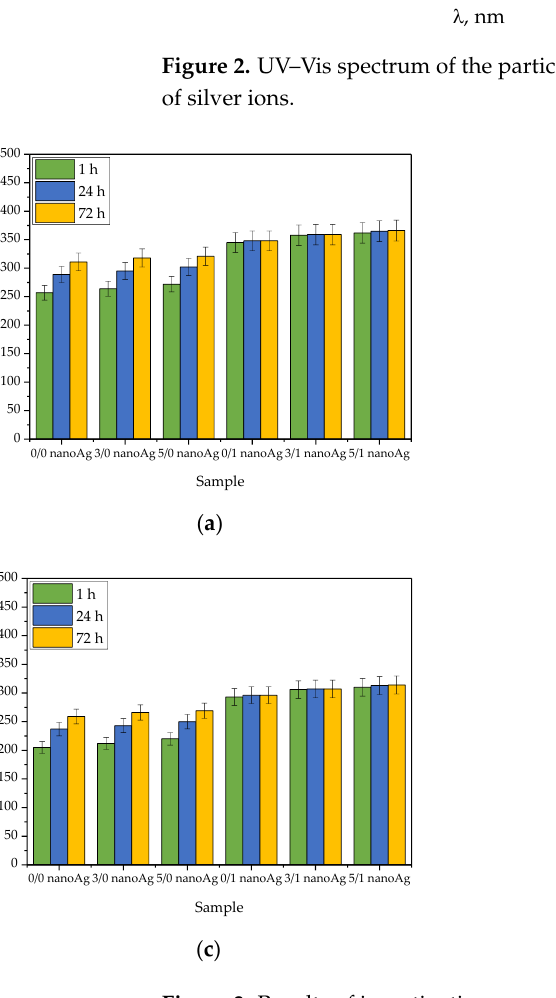
Figure 3. Results of investigations on sorption properties of hydrogels in distilled water ( a ), SBF ( b ), Ringer liquid ( c ), and artificial saliva ( d ) (n = 3, n — number of repetitions).